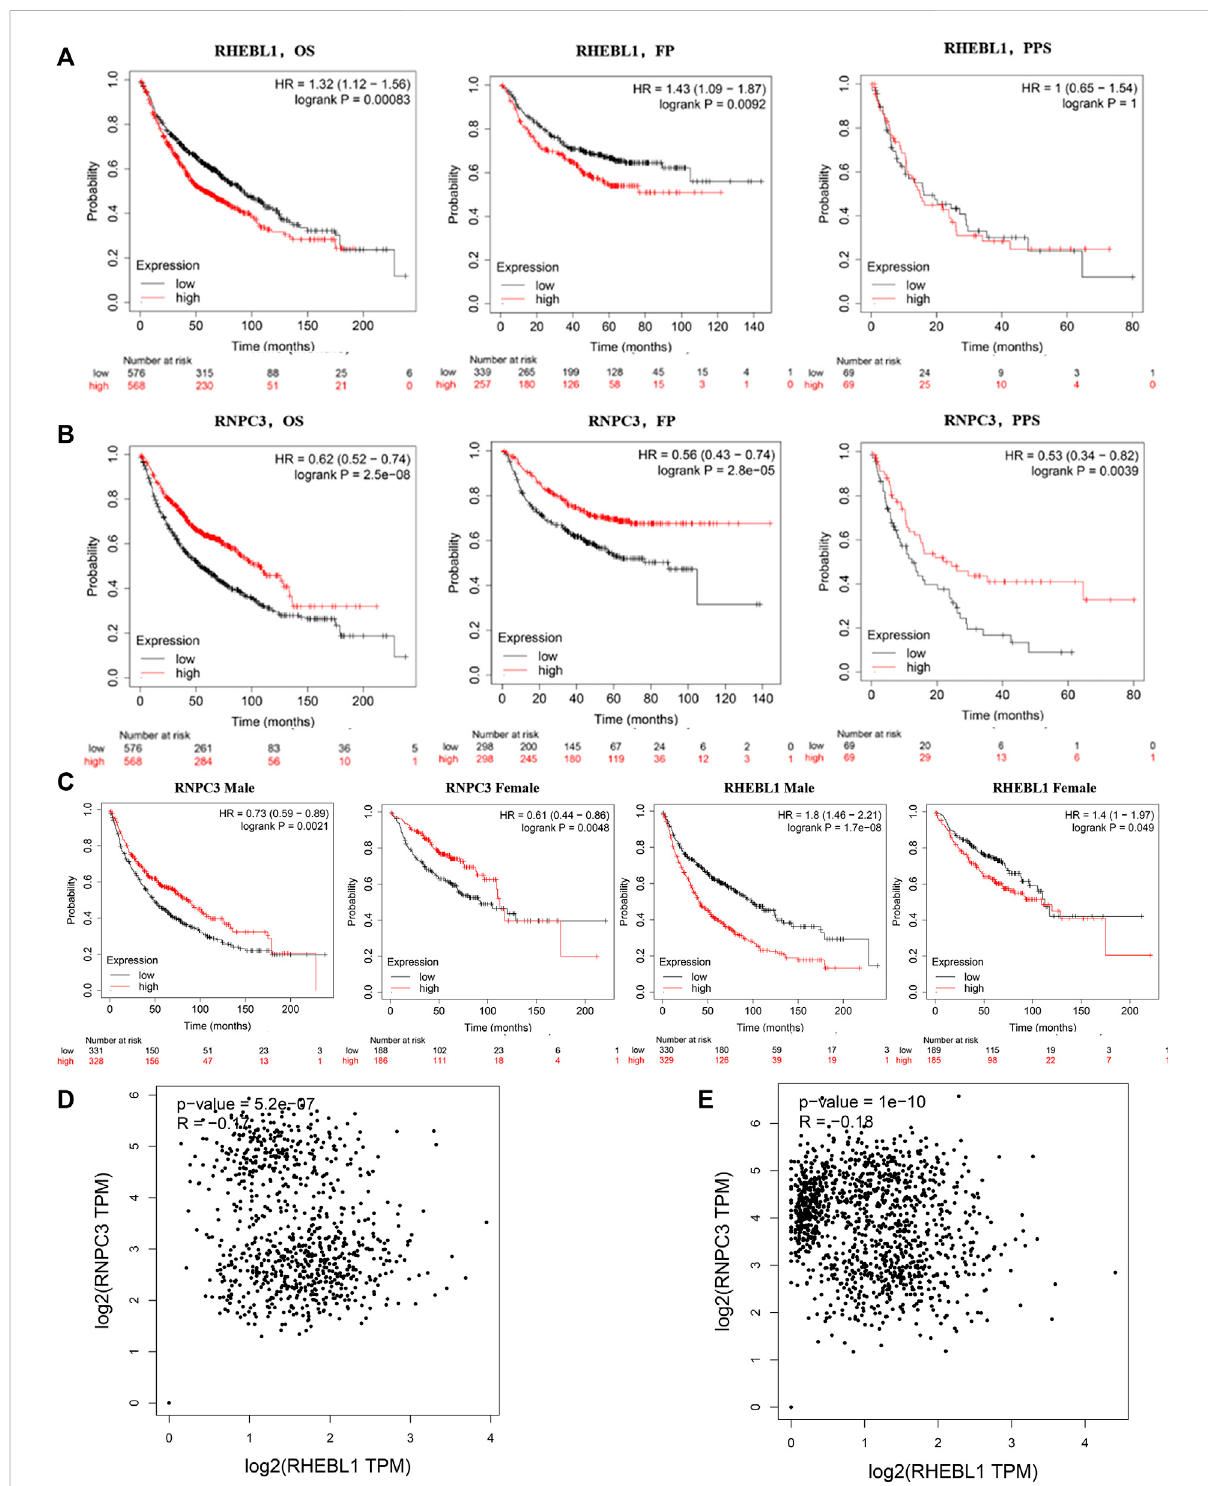
FIGURE 5 Survival curves based on different expression levels of RHEBL1 and RNPC3 in different subgroups of non-small cell lung cancer patients. (A,B) Performance of RHEBL1 and RNPC3 in OS, FP and PPS of non-small cell lung cancer (OS: Overall survival, FP: fi rst-progression survival, PPS: post- progression survival. In OS, FP, high expression of RHEBL1 showed unfavorable prognosis. In addition, high expression of RNPC3 in OS, FP, PPS showedfavorableprognosis). (C) EffectofRNPC3andRHEBL1expressionlevelsindifferentgendersontheprognosisofNSCLCpatients. (D – E) Correlation scatter plot of RHEBL1, RNPC3 in LUSC and LUAD (RNPC3 and RHEBL1 show negative correlation in LUSC and